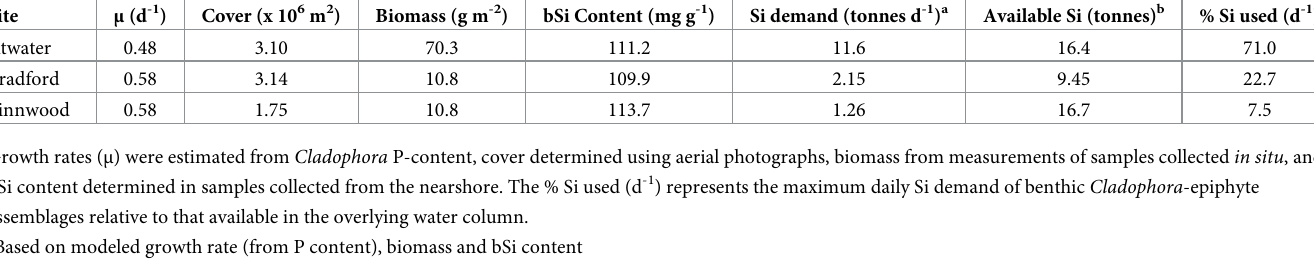
Table 1. Modelled effects of the Cladophora -epiphyte assemblages on dSi at three Lake Michigan nearshore sites. Site μ (d -1 )